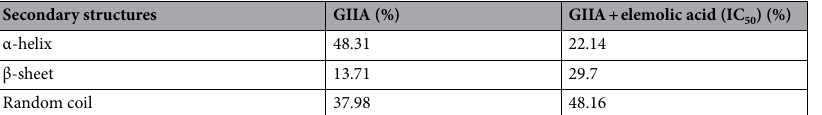
Table 3. Effect of elemolic acid on the secondary structure of GIIA.